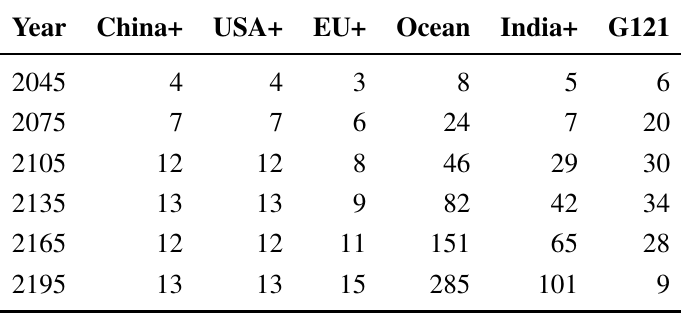
Table 2. Example simulation pot balances in